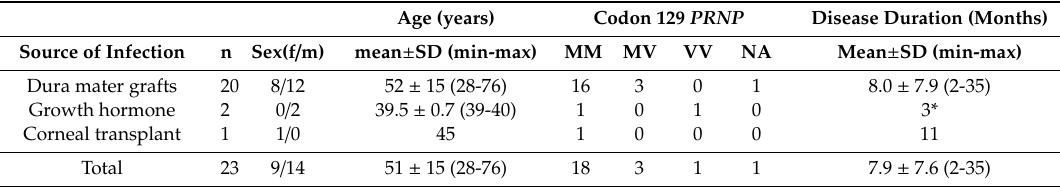
Figure 1. Disease duration in iCJD. Kaplan-Meier survival curves in iCJD stratified by sex. Table 1. Demographic, genetic, and clinical data in iatrogenic CJD. Source of infection, number of cases ( n ), sex (female (f)/male (m)), age at onset in years (mean with standard deviation (SD) and minimum and maximum years), codon 129 genotype (methionine (M), valine (V)), and disease duration in months (mean and standard deviation (SD), with minimum and maximum months) are indicated. NA: not available. * For one case, disease duration was not